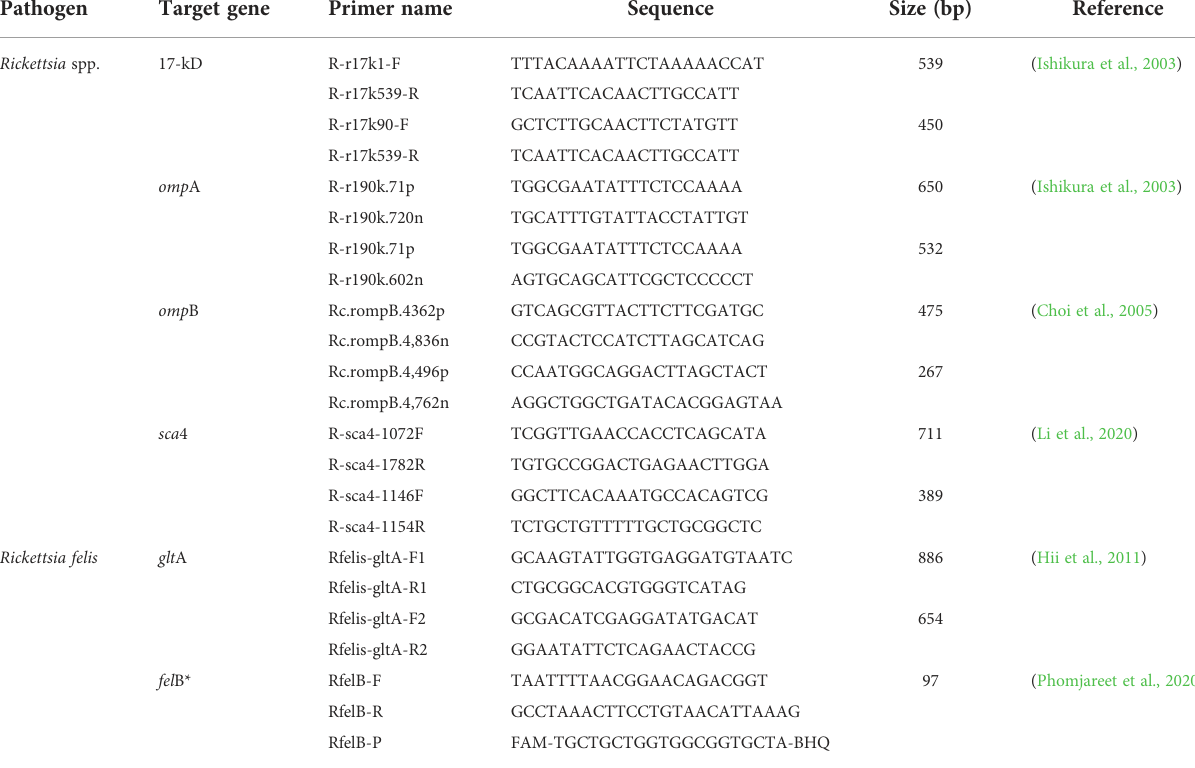
TABLE 1 Primers used in this